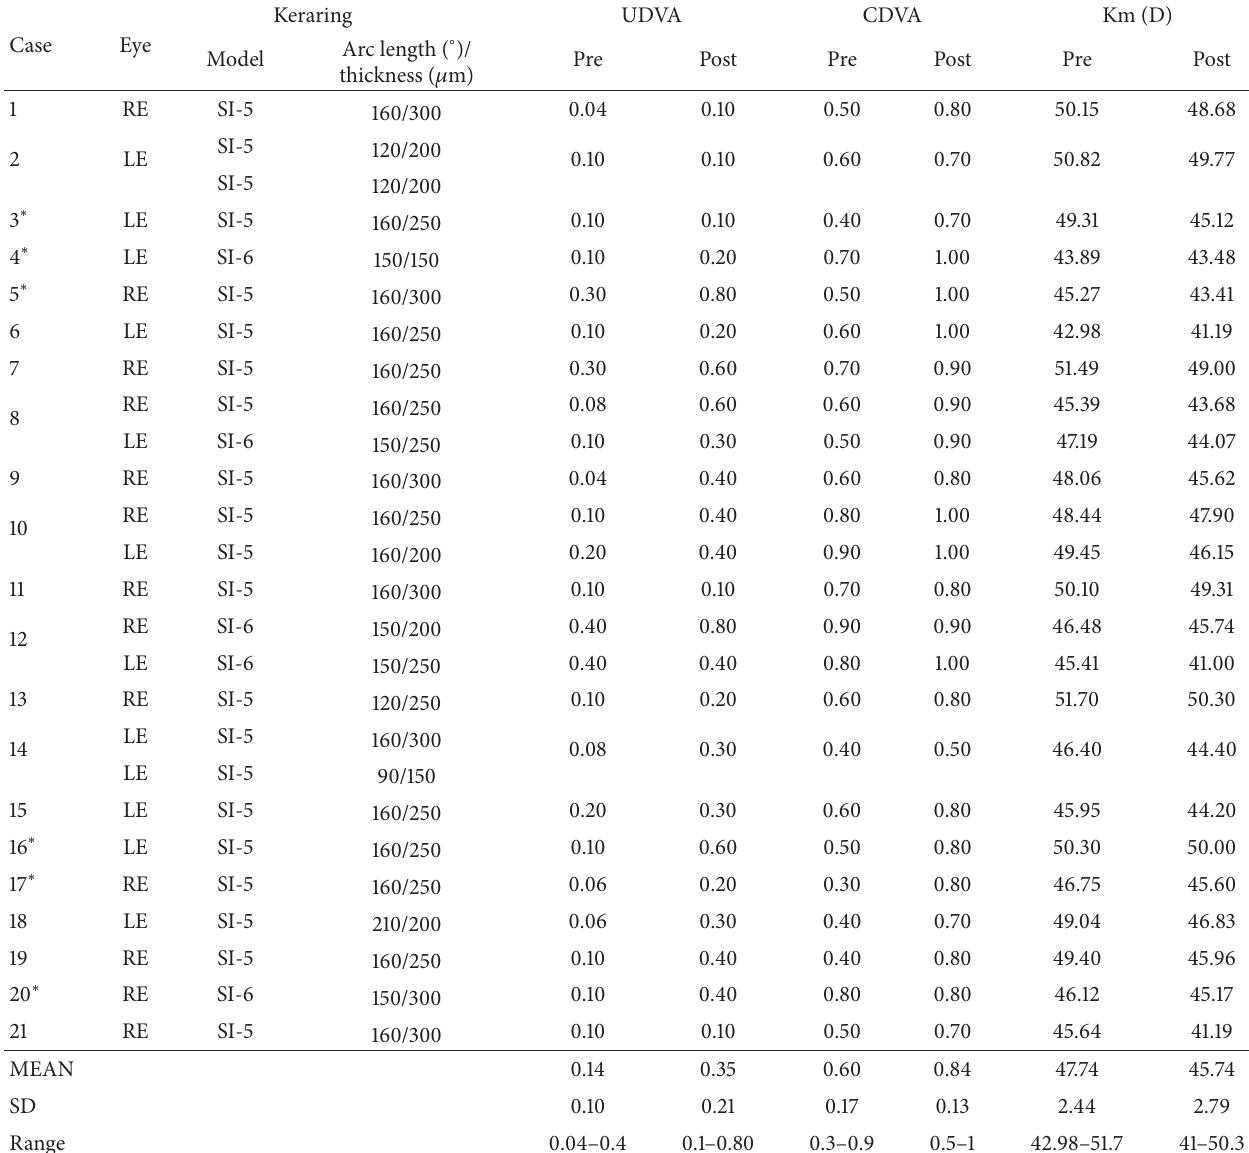
Table1:Keraringcharacteristics,uncorrecteddistancevisualacuity(UDVA),correcteddistancevisualacuity(CDVA),andmeankeratometry (Km) of each